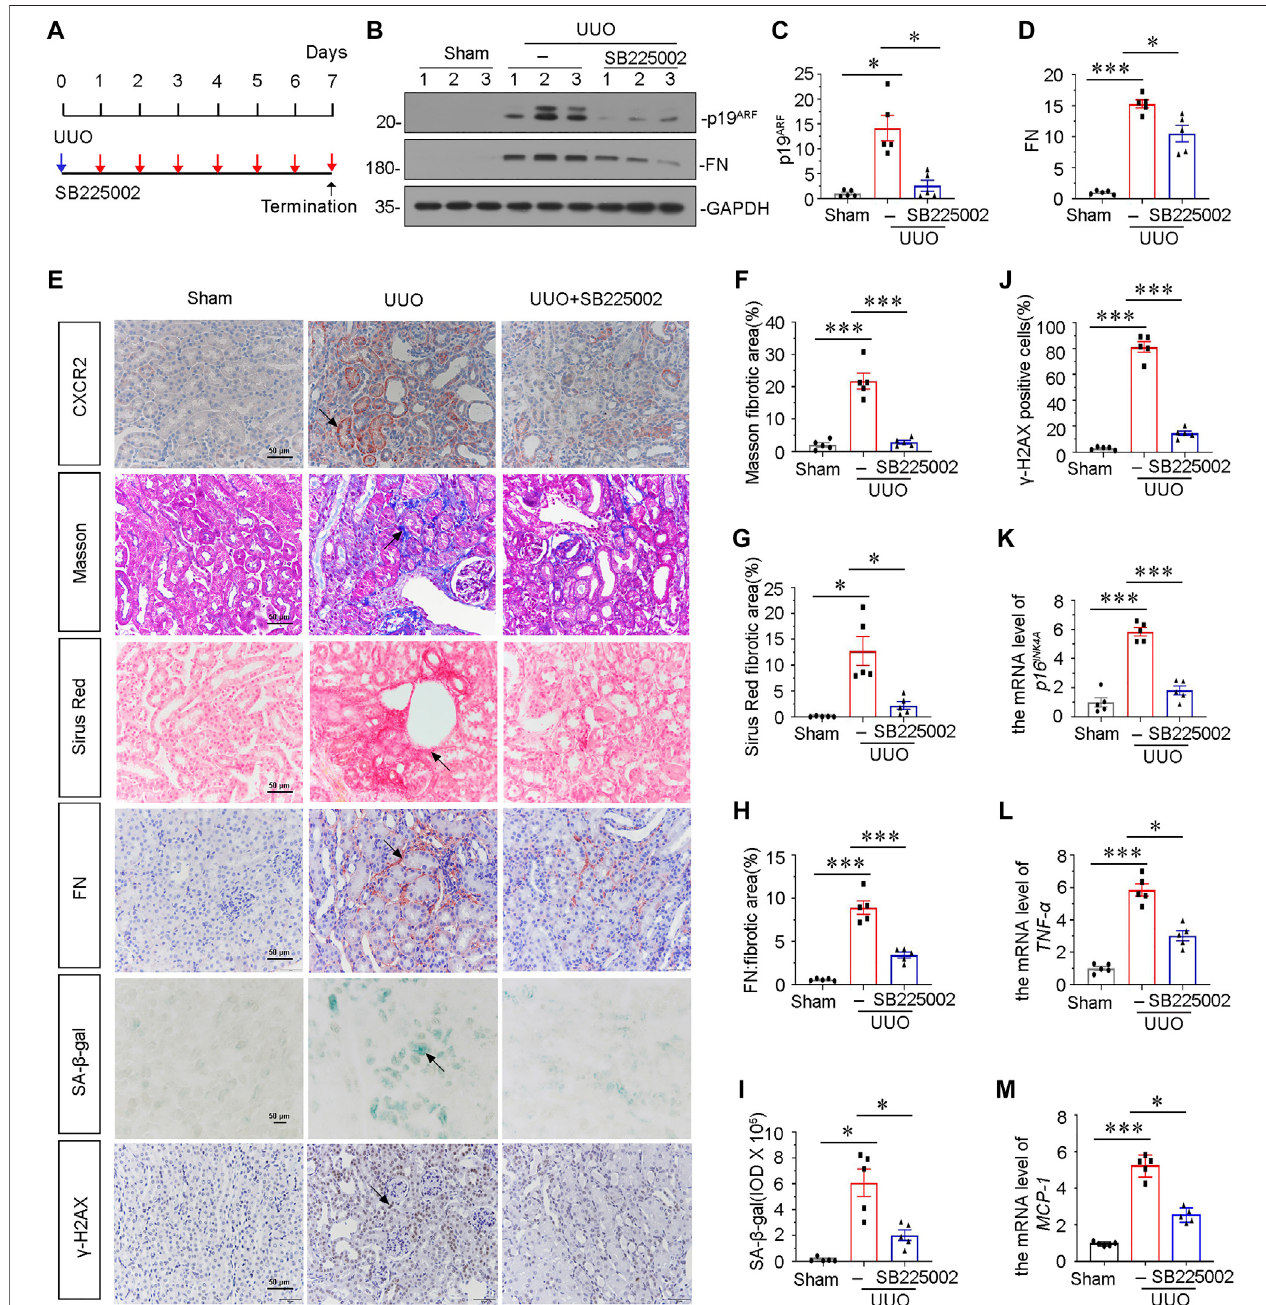
FIGURE 2 | Blockade of CXCR2 with SB225002 ameliorates tubular senescence and renal fi brosis in UUO. (A) Experimental design. Blue arrow indicates the timing of renal UUO surgery. Red arrows indicate the injections of SB225002 (2.5 mg/kg/d). (B) Representative western blots showing renal expression of p19 ARF and fi bronectininthreegroups,asindicated. (C,D) Graphicalrepresentationsof (C) p19 ARF and (D) fi bronectinproteinexpressionallevelsareshown.* p < 0.05,*** p < 0.001, n = 5. (E – J) Representative micrographs showing Masson ’ s trichrome staining, Sirus Red staining, SA- β -gal staining, the fi bronectin and γ -H2AX expression in each group. Frozen renal sections were stained using SA- β -gal kit. Paraf fi n-embedded renal sections were stained by Masson ’ s trichrome staining, Sirus Red staining and immunohistochemical staining. Arrows indicate positive staining. Scale bar, 50 μ m. (F – H) Graphical representation of the extent of fi brosis which was assessed by Masson trichrome staining,Sirus Redstainingand immunohistochemical stainingagainst FN. * p < 0.05, *** p < 0.001, n =5. (I) Quantitativegraph ofSA- β -gal stainingin different groups, as indicated. * p < 0.05, n = 5. (J) Quantitative graph of the percentage of γ -H2AX positive cells in different groups, asindicated. *** p < 0.001, n = 5. (K) Graphicalrepresentationsshowtherelativeexpressionofp16 INK4A mRNAlevelindifferentgroups.*** p < 0.001, n =5. (L,M) Graphicalrepresentationsshowtherelative abundance of TNF- α and MCP-1 mRNA in different groups. * p < 0.05, *** p < 0.001, n = 5.